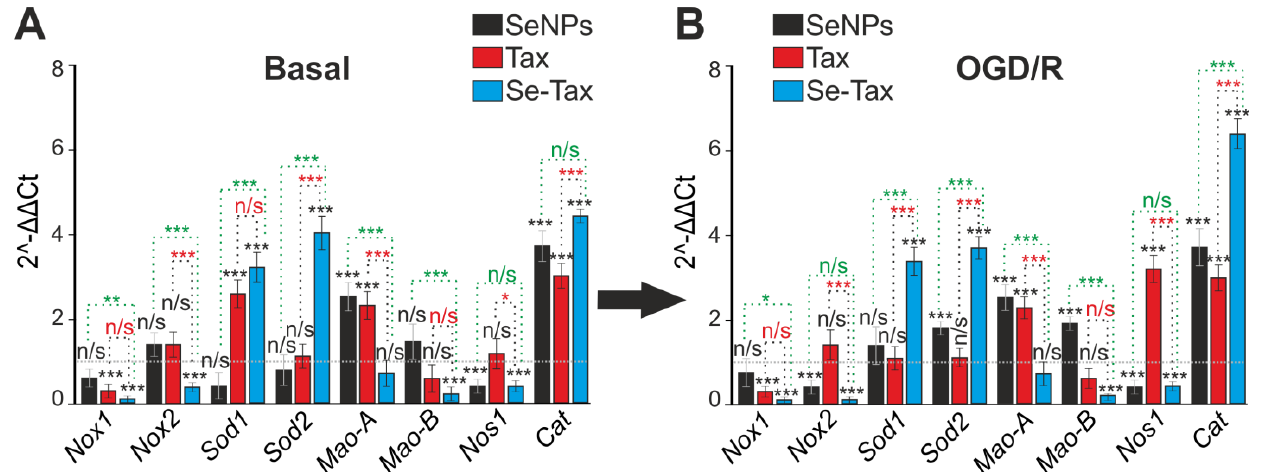
Figure 8. The effect of 24 h incubation of mice cortical cells with 3 μg/mL taxifolin (TAX), 3 μg/mL SeNPs, or 3 μg/mL Se – TAX on the basal ( A ) and OGD/R-affected ( B ) expression of genes regulating cellular antioxidant status. Gene expression in intact cells are marked with a dashed line for panel ( A ). Gene expression in OGD/R cells without treatment with test compounds is marked with a dashed line for panel ( B ). Statistical significance was assessed using t -test. Comparison of experimental groups with control: n/s — data not significant ( p > 0.05), * p < 0.05, ** p < 0.01, and *** p <0.001. Comparison of experimental groups with each other is indicated in red or green. The number of samples is 3.